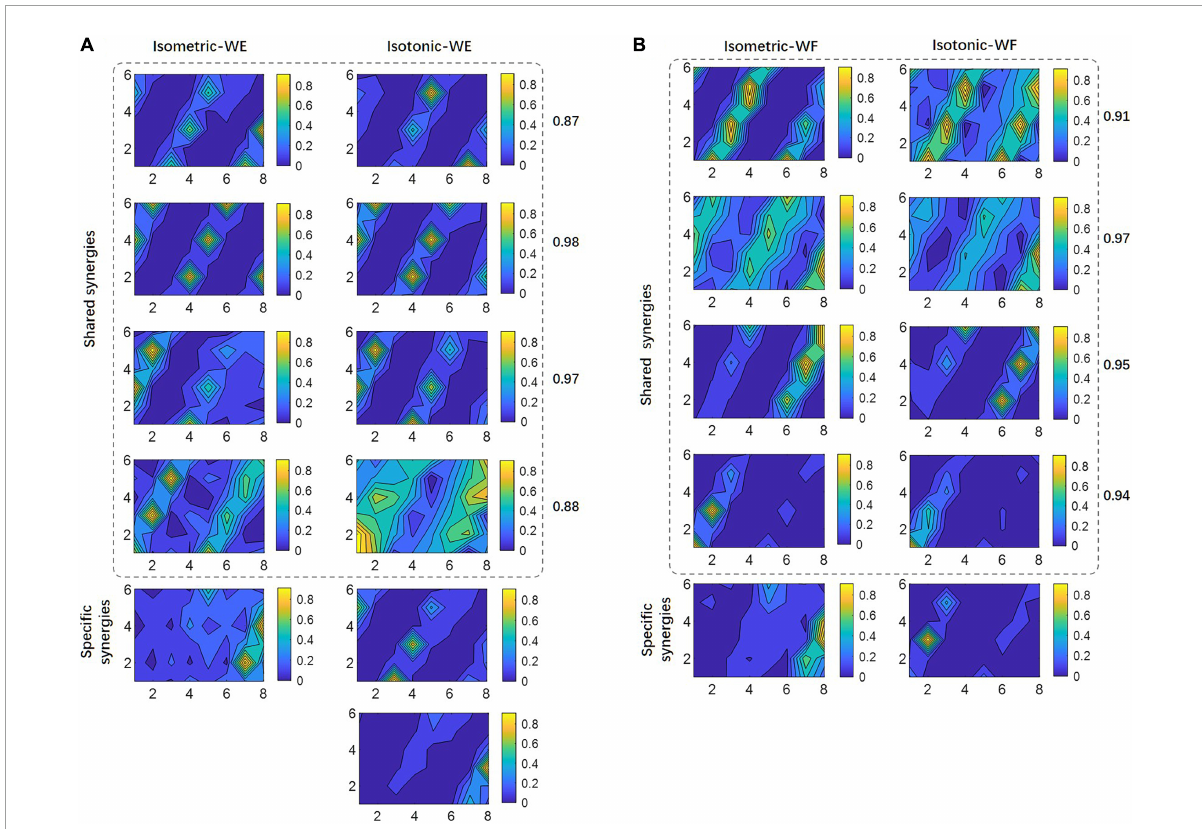
FIGURE6 Shared synergies by two training modes and mode-specific synergies. For (A) WE and (B) WF, all synergy vectors after clustering are illustrated in 6 × 8 contour plots. Numbers denote the CPA between paired synergy vectors.